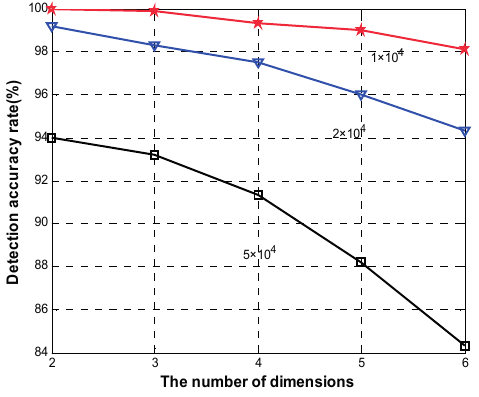
Figure 11. Detection accuracy rate for different data sizes of DFD-M.